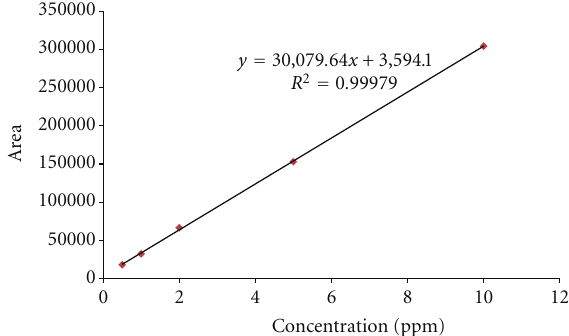
Figure 3: Result of calibration slope using N 2 O standard gas.